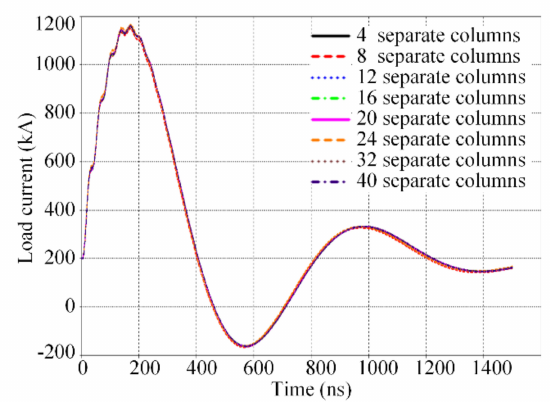
Figure 23. Simulated load current waveforms with the change of number of separate